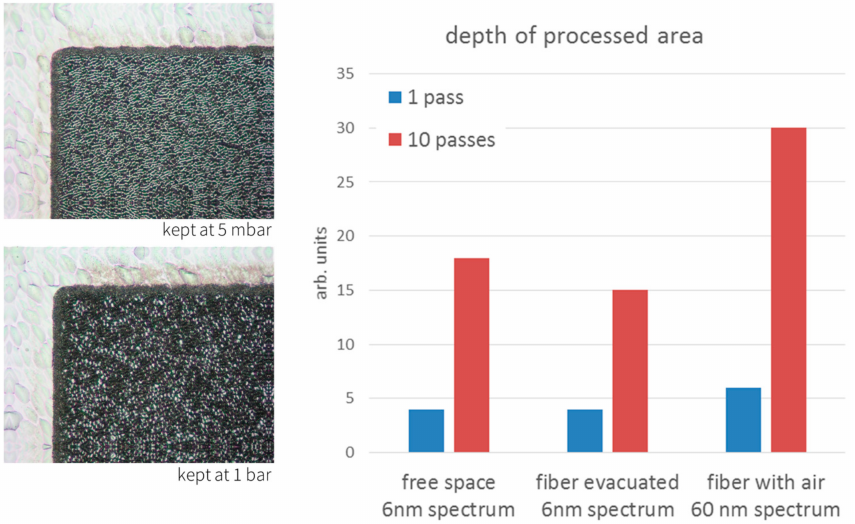
Figure 10. Surface modification on polychristalline silicon with spectrally broadened pulses. Ablation depths and structure sizes with pulse bandwidth change from 6 nm to 60 nm were